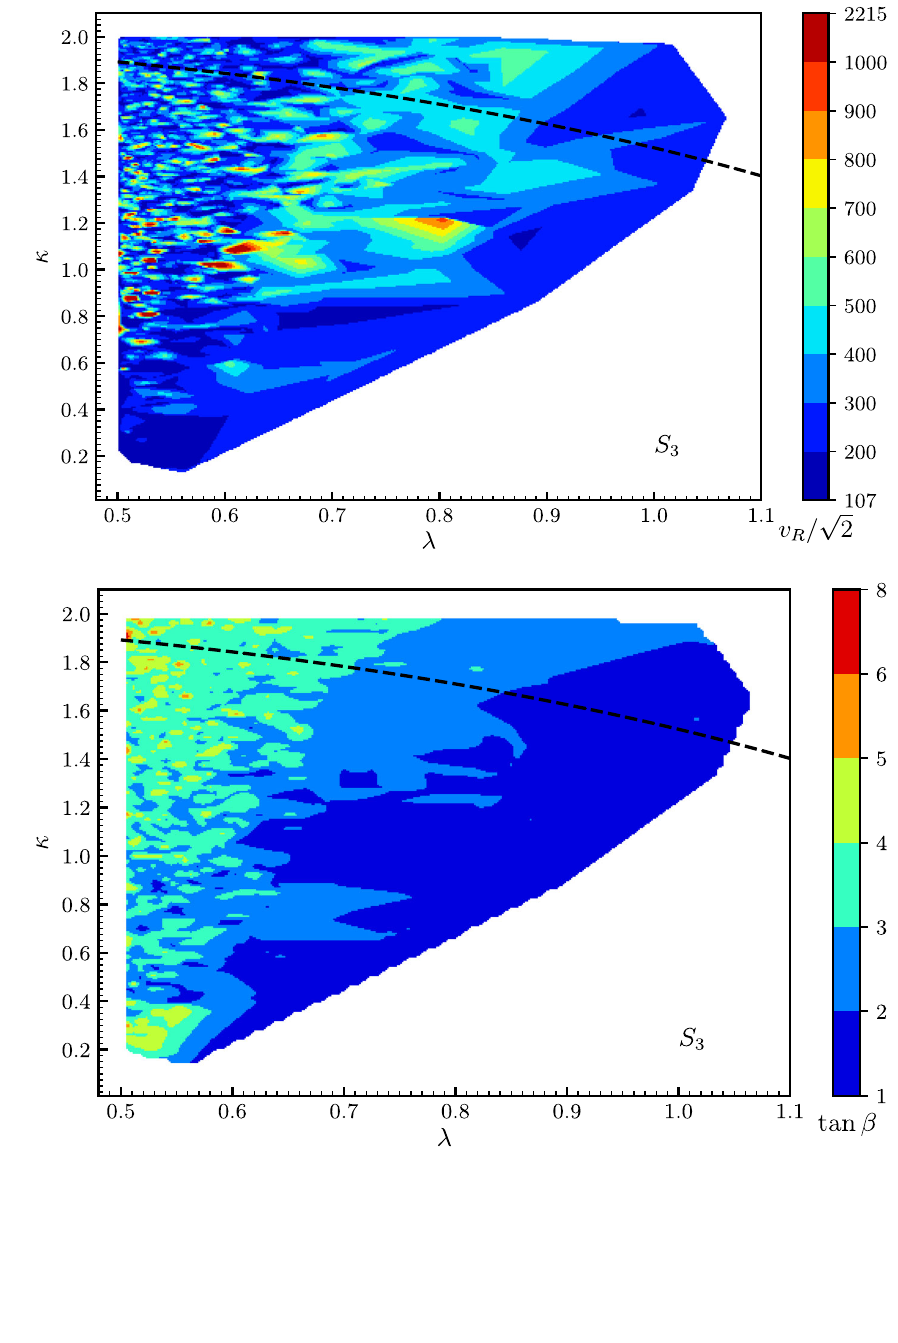
Fig. 32 Viable points of the parameter space for S 3 in the κ − λ plane. The points below the dashed line fulfill the condition of Eq. (26), where perturbativity is relaxed up to 10 TeV. The colours indicate different values of the right √ sneutrino VEVs v R / 2